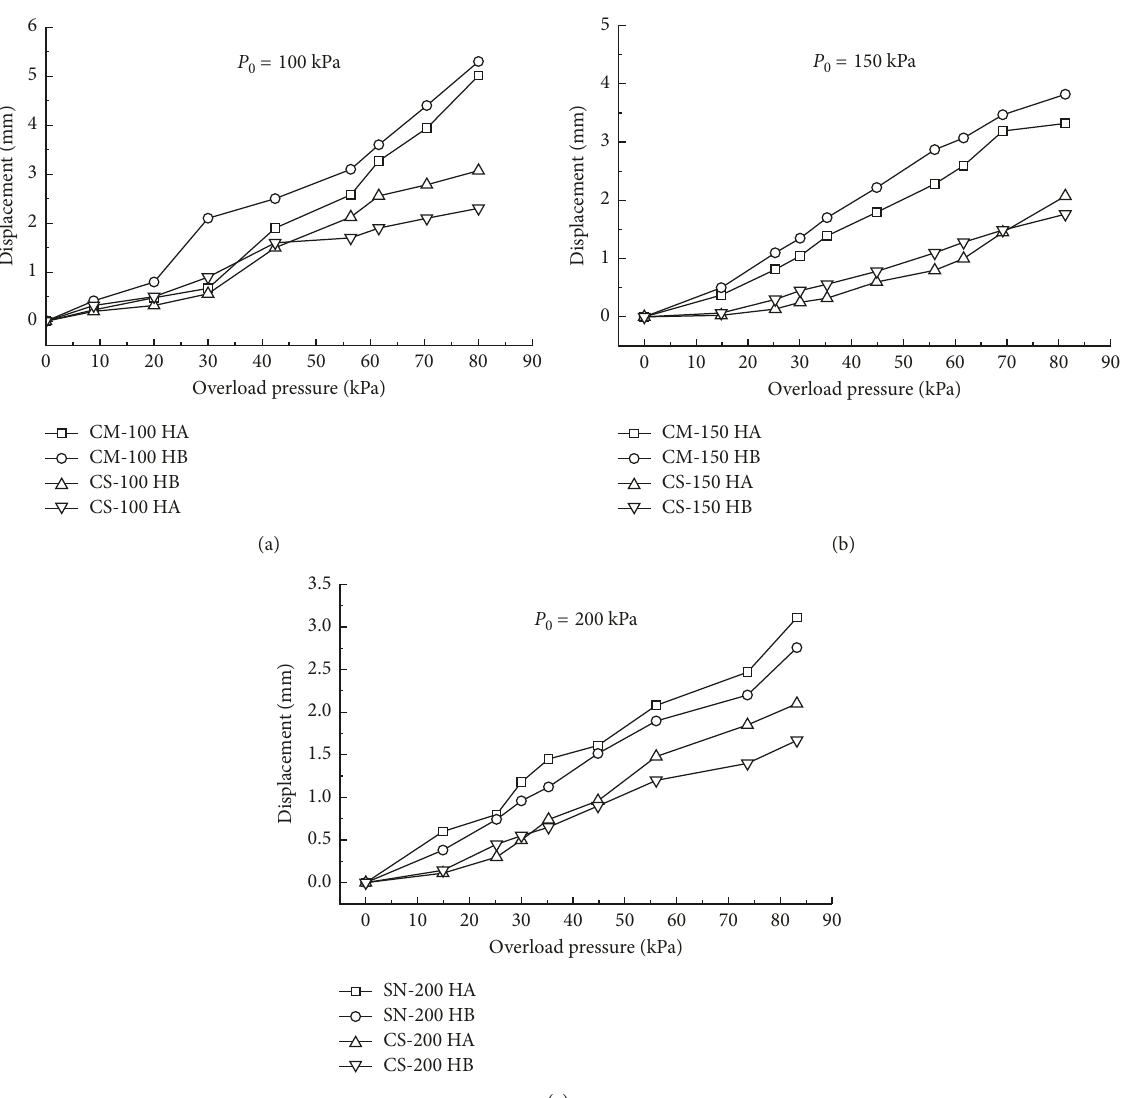
Figure 12: The relationship between horizontal displacement and overload pressure: (a) initial pressure P P 0 � 150kPa, and (c) initial pressure P 0 �